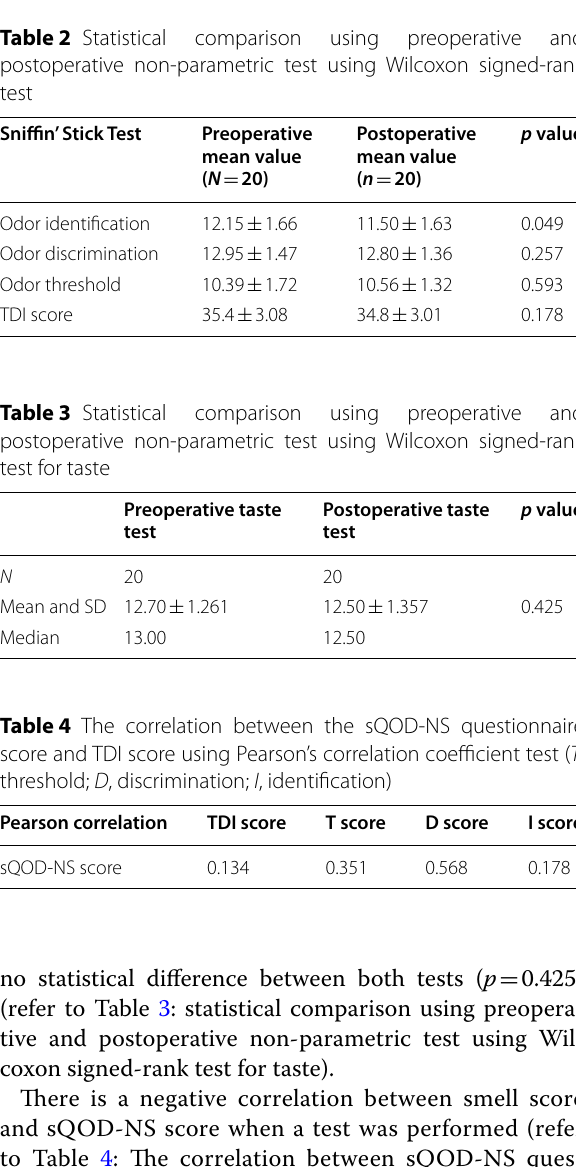
to Table 4: The correlation between sQOD-NS ques- tionnaire score and TDI score using Pearson’s correla- tion coefficient test (T: threshold, D: discrimination, I: identification).